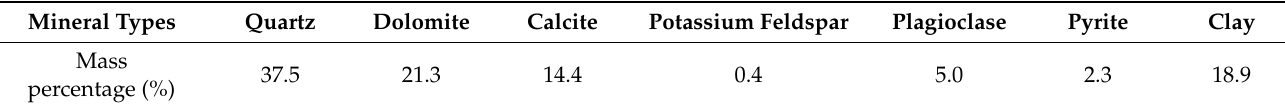
Table 1. Rietveld refinement results of the shale samples.